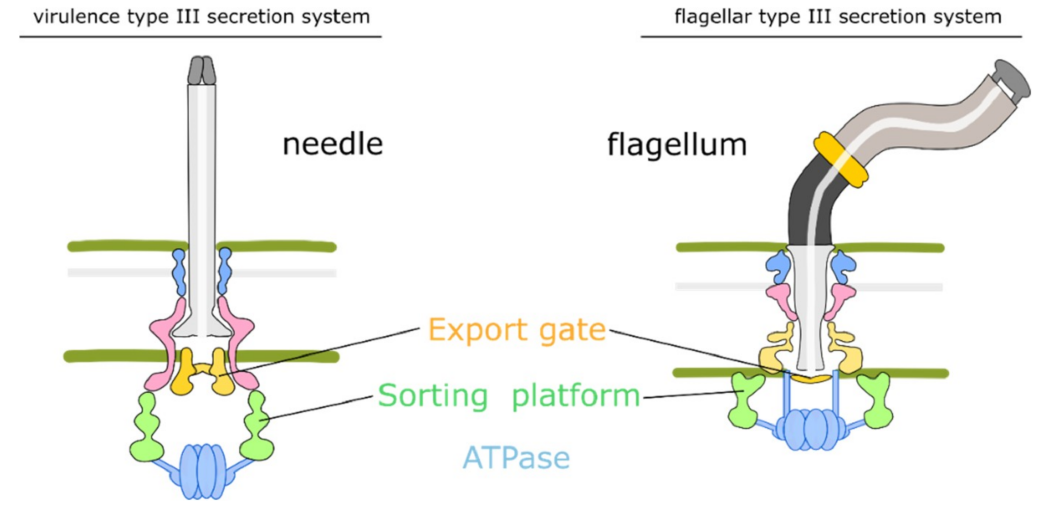
Figure 2. Schematic of vT3SS and fT3SS. The vT3SS and fT3SS are similar in terms of cytoplasmic components and the inner membrane export apparatus. ATPase associates with proteins to pump unfolded substrates into the export channel. Then, the sorting platform and export gate help line up the sequence of unfolded substrates. The flagellum consists of a rod, hook structure, and flagellar filament. The needle connects with rings to directly pass through the outer